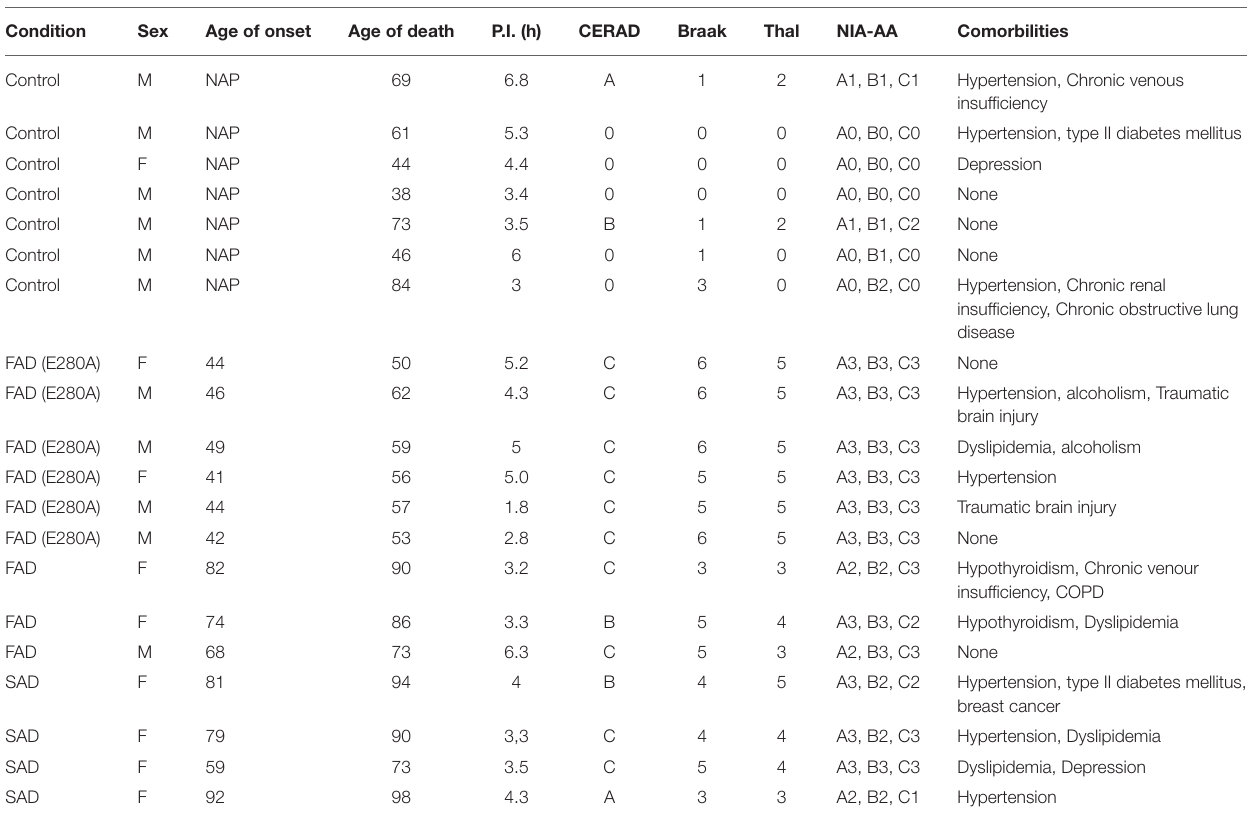
TABLE 1 | Description of post-mortem